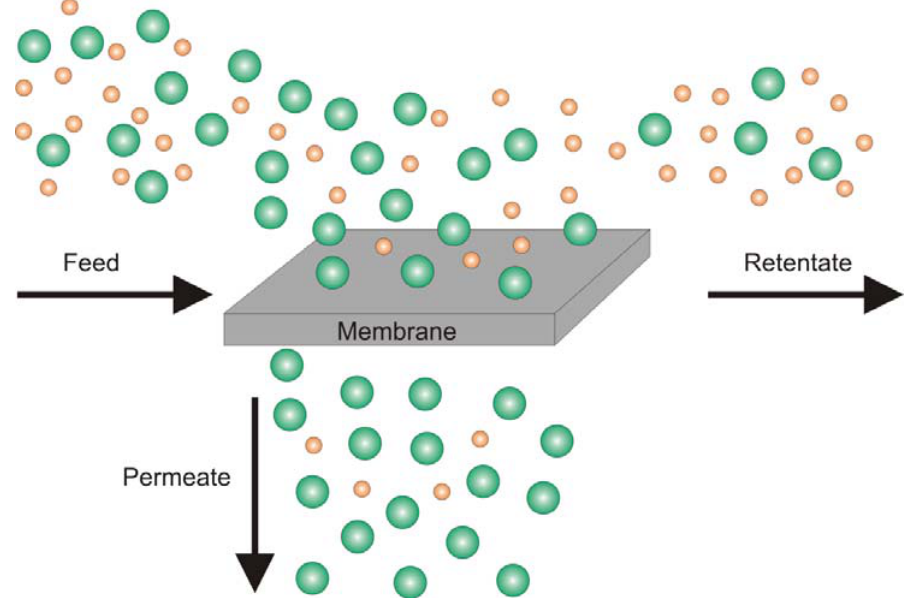
Figure 1. Principles of pervaporation. The liquid feed mixture fl ows along the membrane and the feed components diffuse into and through the membrane at different rates. The liquid retentate is depleted and the vaporous permeate enriched in the preferentially permeating component